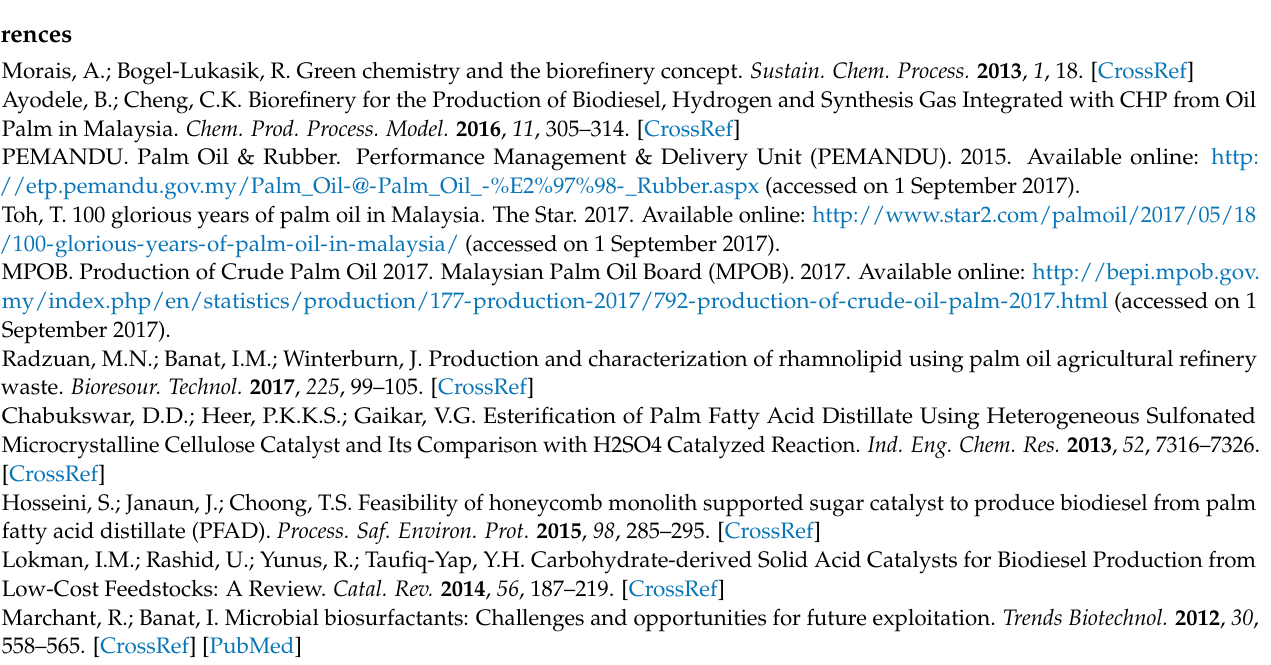
Figure S2: Rhamnolipid critical micelle concentration from (a) PFAD and (b) FAME, Table S1: Critical micelle concentration determination using the intersection of two